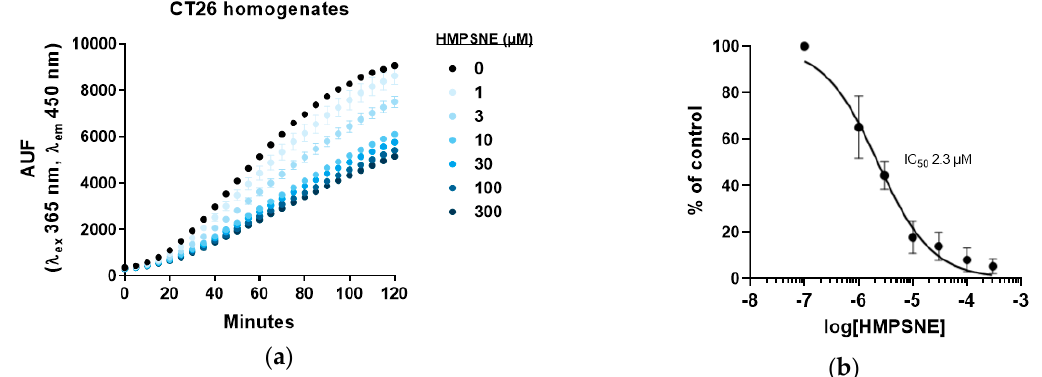
Figure 3. 3-MST activity in CT26 homogenates measured with AzMC in presence of HMPSNE: ( a ) Representative curves of H 2 S production after incubation with serial dilutions of HMPSNE, in presence of 500 µM 3-MP and 10 µM AzMC. Data are presented as mean ± SEM of three replicates; ( b ) Concentration response of HMPSNE represented in percentage of control as mean ± SEM of three independent experiments.